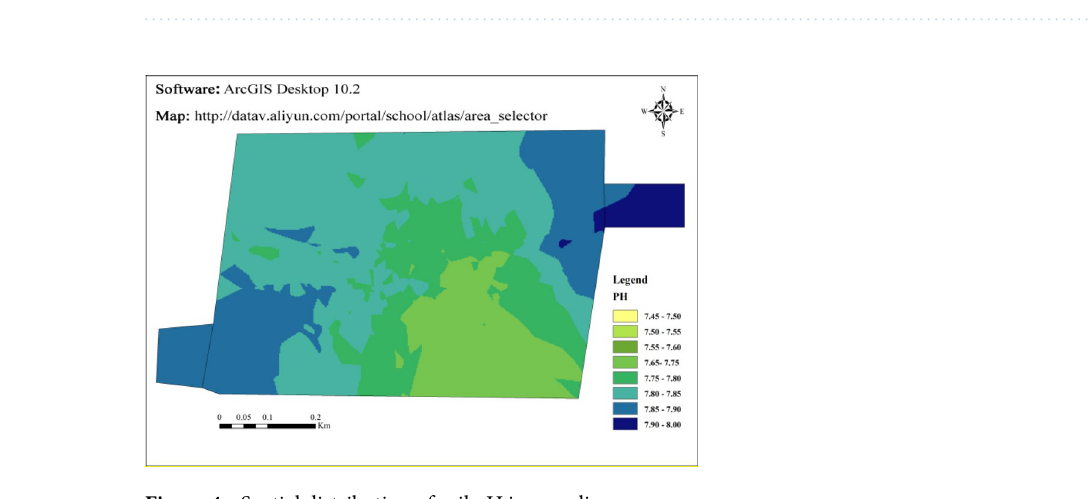
Figure 3. Box-plot of soil pH distribution.